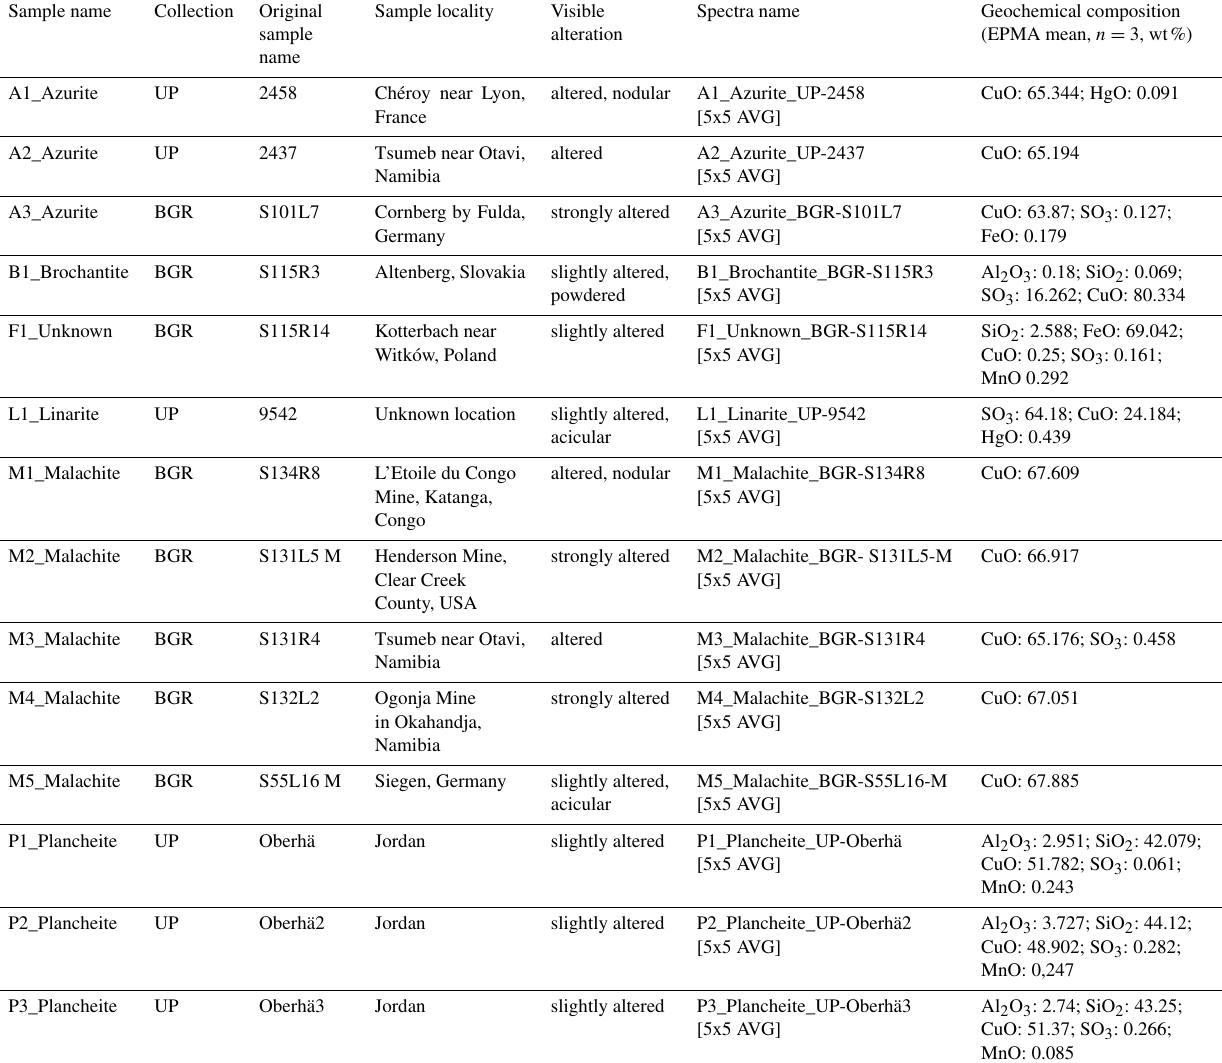
Table 11. Sample names, collection, original sample name, locality, alteration, mineral formula, spectral library filenames and geochemical composition of the copper-bearing silicates, carbonates and